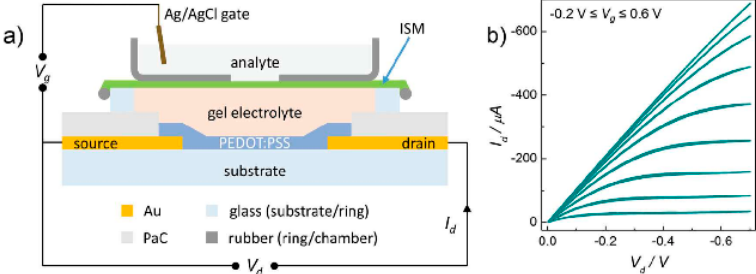
Figure 1. ( a ) Cross-section scheme of an ion-selective organic electrochemical transistor (IS-OECT) based on an ion-sensitive membrane (ISM), and ( b ) output curve of the device recorded in aqueous 10 − 3 M KCl. Reproduced from Sessolo et al. [27]. Copyright © 2014, John Wiley and Sons.